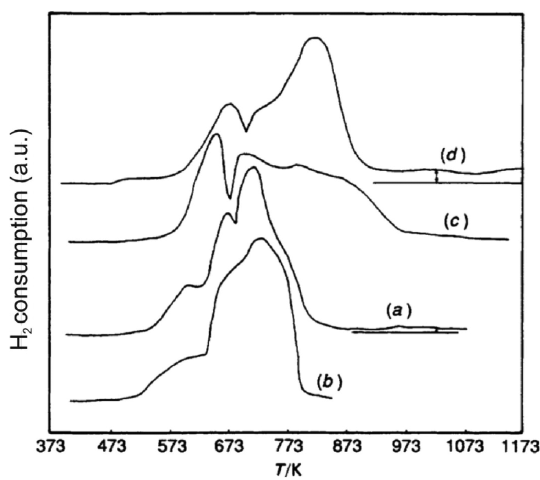
Fig. 1 – TPR profiles for (a) physical mixture (H 2 :Co = 1 . 34); (b) Co 23 O 34 (H 2 :Co = 1 . 30); (c) Co/Al 2 O 3 (H 2 :Co = 1 . 33) and (d) Co/Nb 2 O 5 (H 2 :CO = 1 . 49) (Rosenir et al.